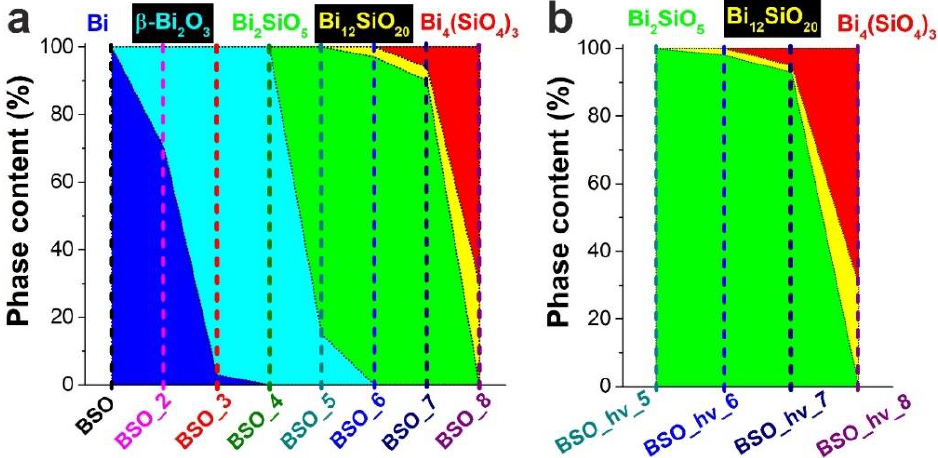
Figure 3. Phase composition of the samples and its evolution with thermal treatment. ( a ) Samples BSO, and ( b ) samples BSO_h ν . Areas of phase presence are colored with same colors as their labels on the